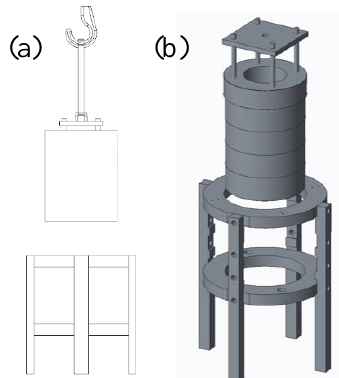
Figure 3. The physical experimental setup for testing the precision of a sensor concept. There is a 2D blueprint ( a ) on the left and rendered 3D model ( b ) of the setup on the right.